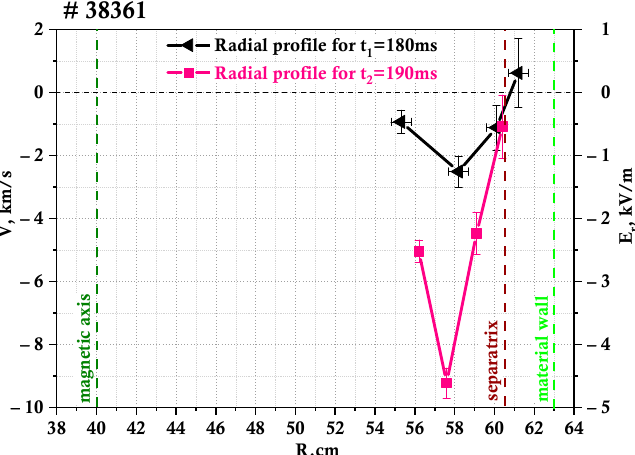
Radial profile for t 1 =180ms Radial profile for t 2 =190ms